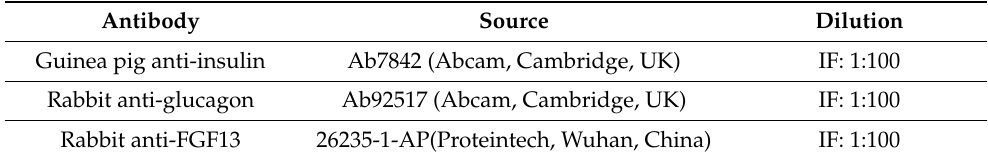
Table 2. Antibodies for